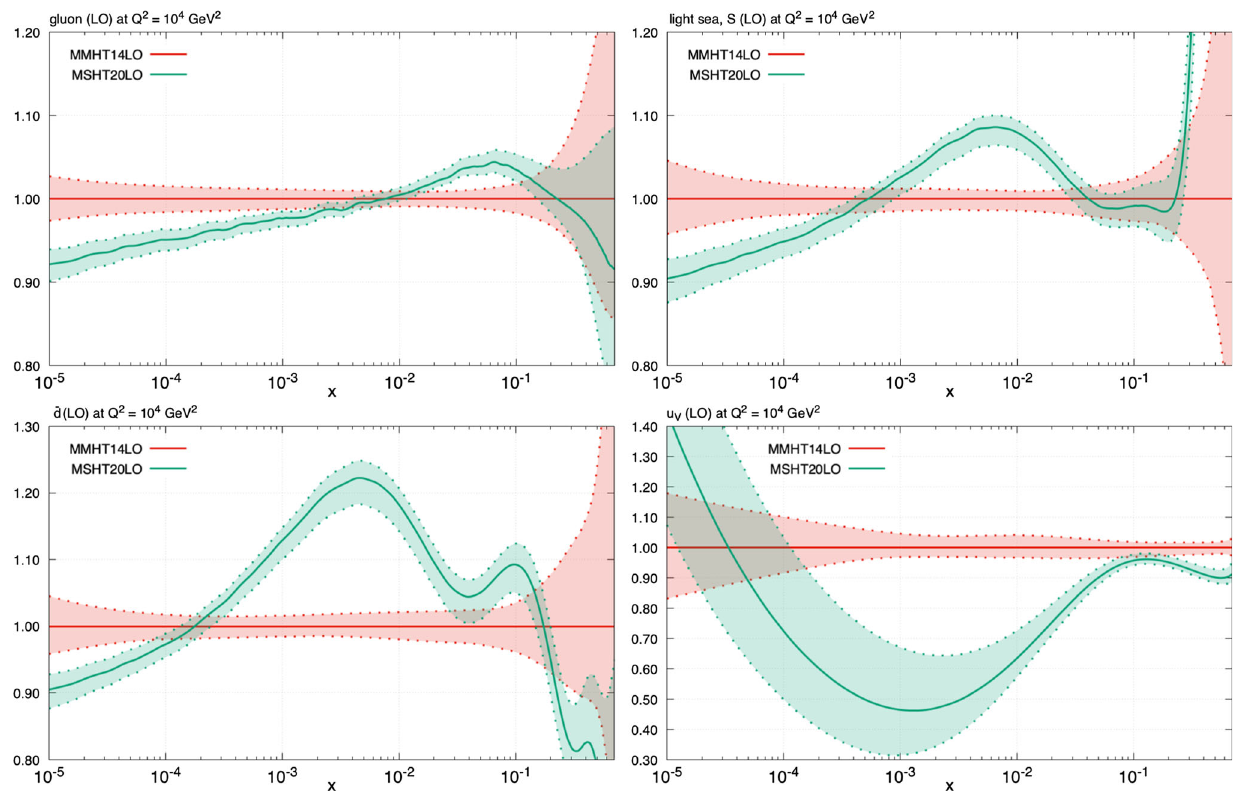
Fig. 42 Ratio of MSHT20 LO to MMHT14LO PDFs at Q 2 = 10 4 GeV